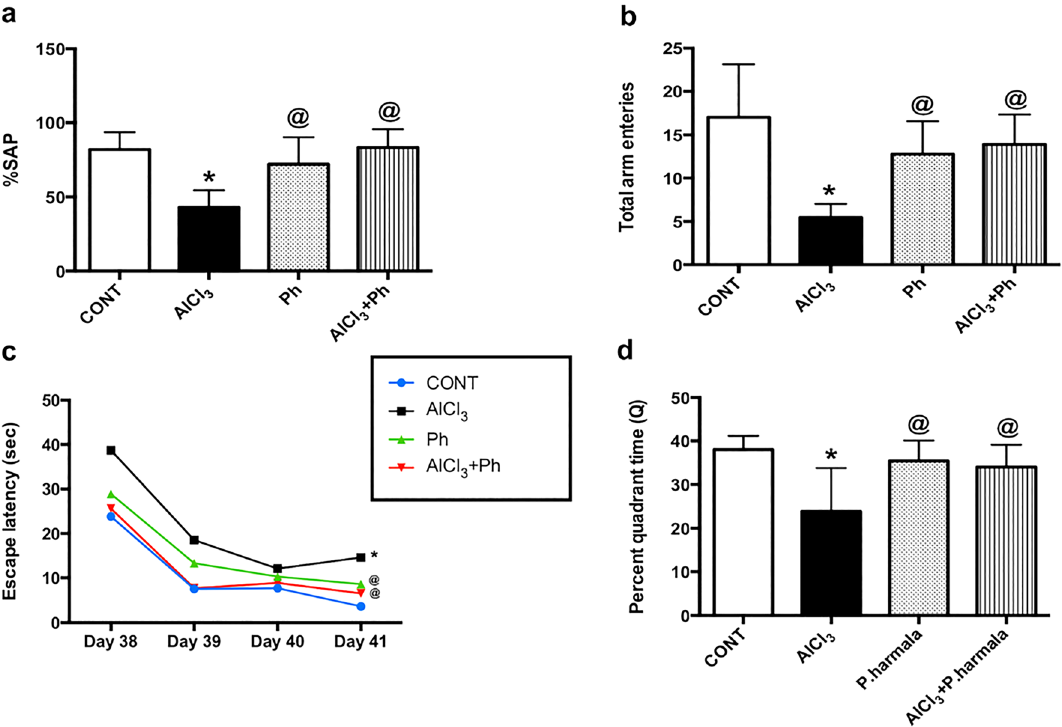
Figure 3. Effect of P. harmala on AlCl 3 -induced: ( a ) % SAP and ( b ) total arm entries in Y-maze test and ( c ) learning and ( d ) memory deficits in MWM paradigm. Values represent mean ± SD (n = 13). Statistical analysis was carried out using one-way ANOVA for %SAP and total arm entries in Y-maze and percent quadrant time in the probe MWM test, while two-way ANOVA was used for the escape latency in the training session of MWM test followed by Tukey’s Multiple Comparisons test. Significantly different from (*) CONT and (@) AlCl 3 groups at p < 0.05. AlCl 3 aluminum chloride, CONT control, MWM Morris Water Maze, Ph Peganum harmala , %SAP spontaneous alternation